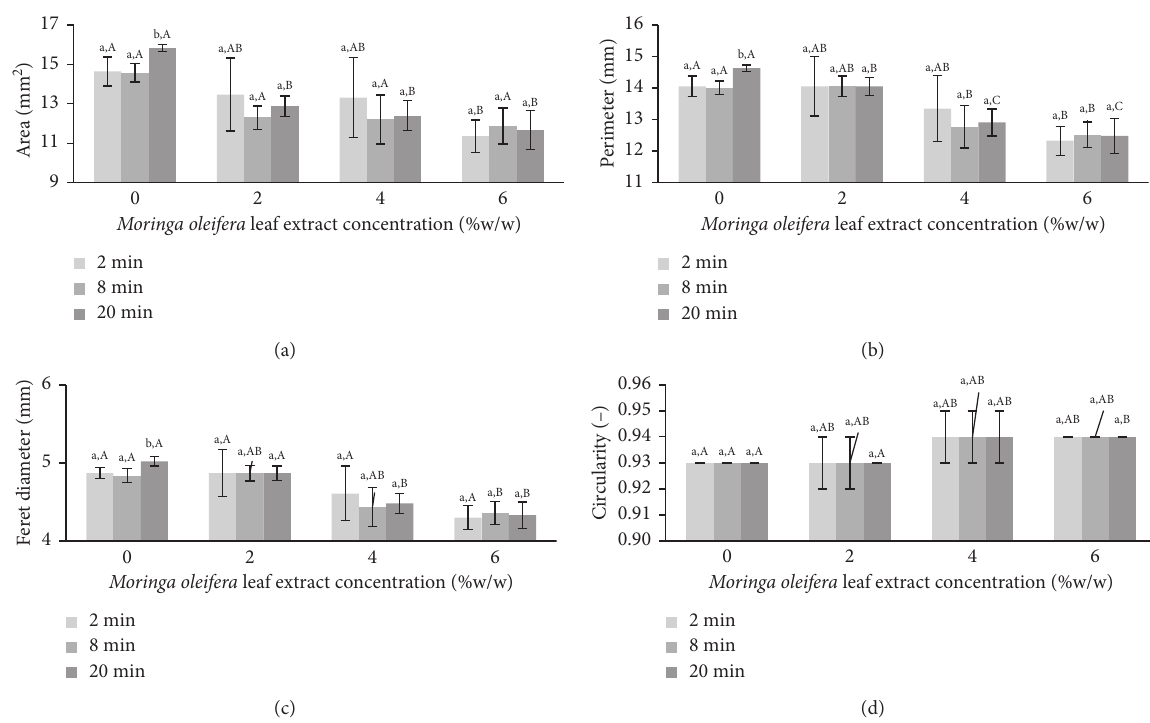
Figure 2: Geometric properties of chocolate alginate beads as affected by MLE concentration (0, 2, 4, and 6% w/w) and hardening time (2, 8, and 20min). Different small letters indicate significant differences among samples of the same concentration, while different capital letters indicate significant differences among samples of the same hardening time at p < 0 .